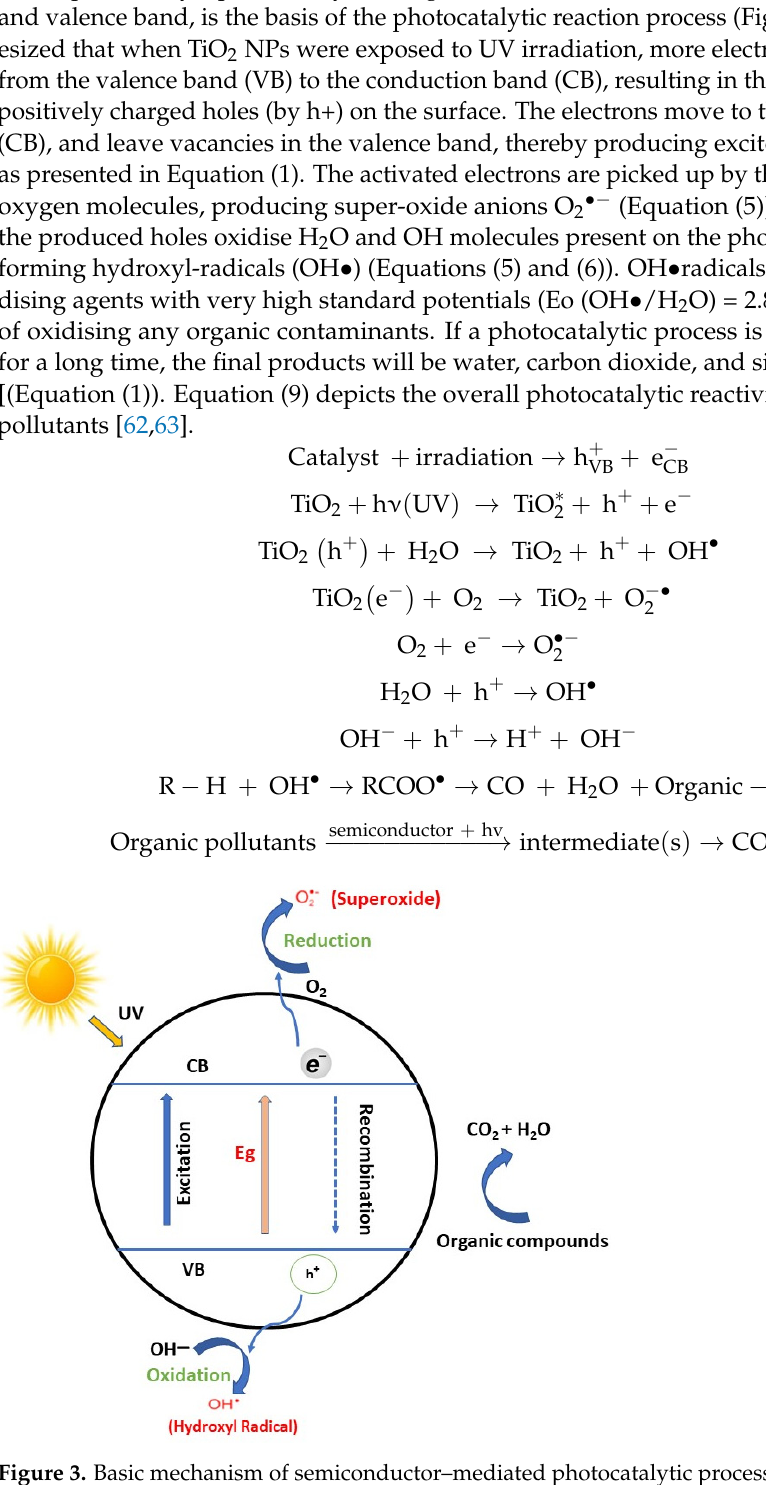
Figure 3. Basic mechanism of semiconductor–mediated photocatalytic process.